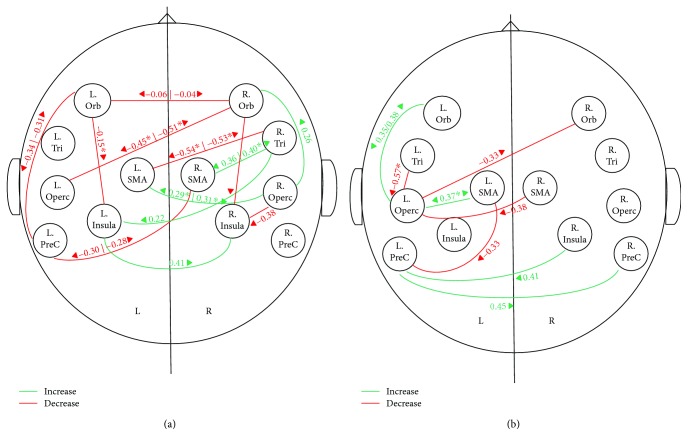
Changes in resting-state connectivity during the treatment interval in the treated patient JV (a) and control patient GB (b). Increase: green; decrease: red. Values represent differences (T3 − T2) in the semipartial correlation. Arrows point to the target region in the calculation of semipartial correlations. Only changes in T3 − T2 which were significantly greater than changes during the baseline period (T2 − T1) are shown. Significance is determined with FDR correction for 66 correlations with p < 0.05 or p < 0.01 (marked by∗). L: left; R: right; Orb: orbitalis; Tri: triangularis; Operc: opercularis; PreC: precentral; SMA: supplementary motor area.